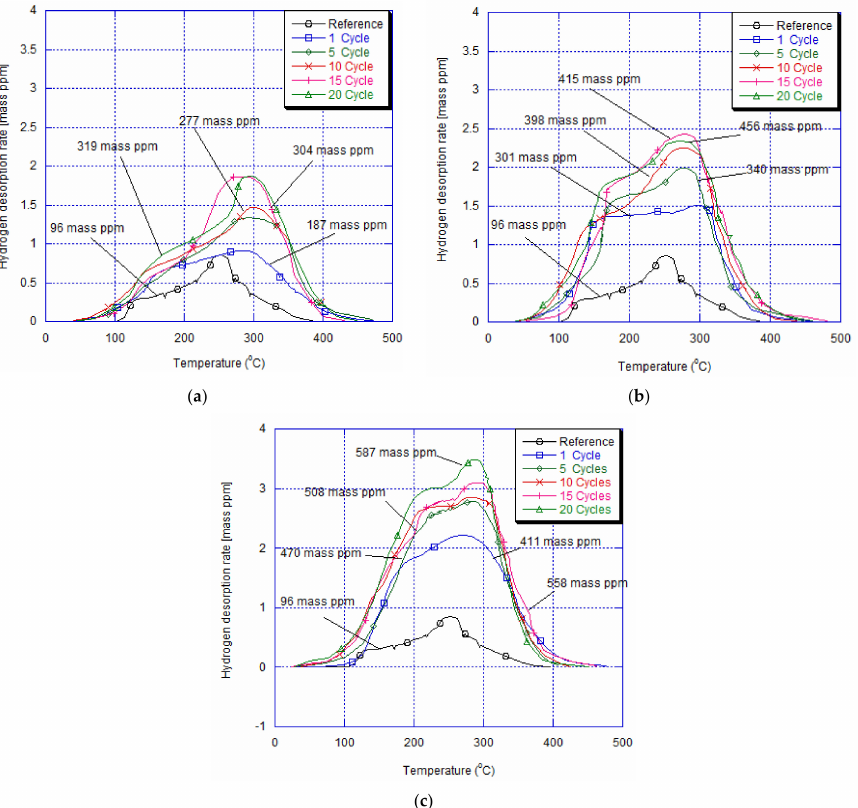
Figure 7. Hydrogen thermal desorption curves for specimens immersed for 3 h and aged for 24 h at room temperature after 13 cycles with imposed deformation of ( a ) 10 − 5 s − 1 , ( b ) 10 − 4 s − 1 and ( c ) 10 − 3 s − 1 , showing an increase in the amount of absorbed hydrogen with stain